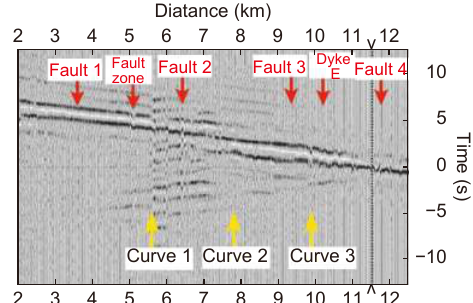
Fig. 6 | Ambient noise based, cross-correlation computed between all Φ-OTDR traces of the cable with respect to one ar- bitrary trace (at position ~11.5 km) showing several geological features. Figure reproduced from supplementary material of ref. 98